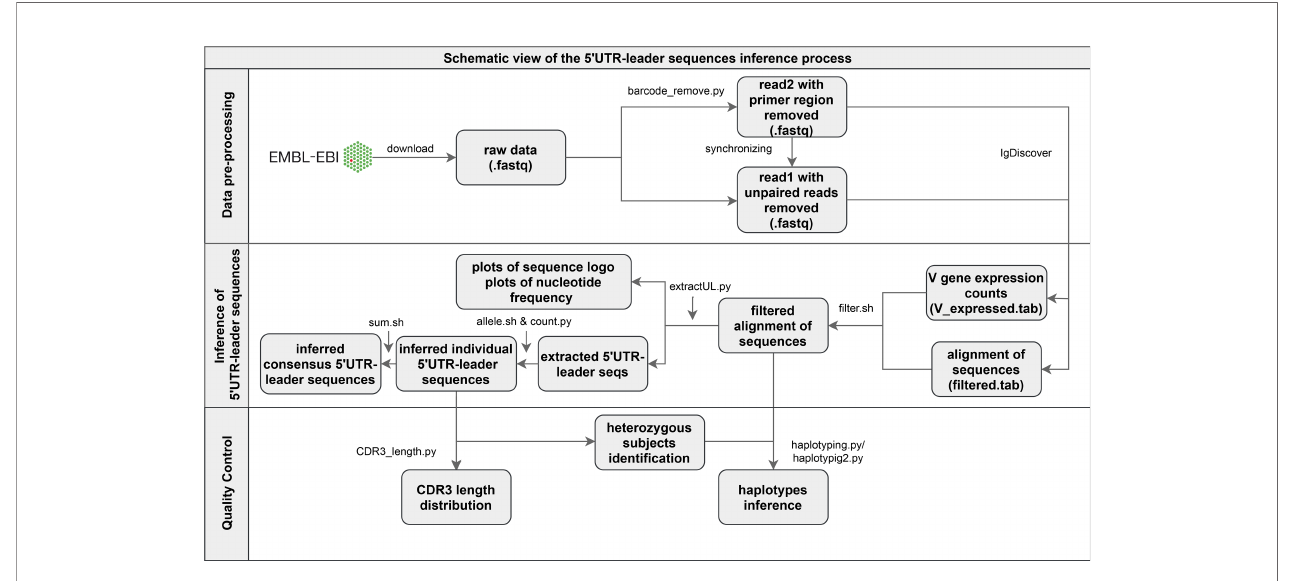
FIGURE 1 | Schematic illustration of the pre-processing of Illumina MiSeq paired-end reads and of the pipeline of 5 ’ UTR-leader sequences inference and validation